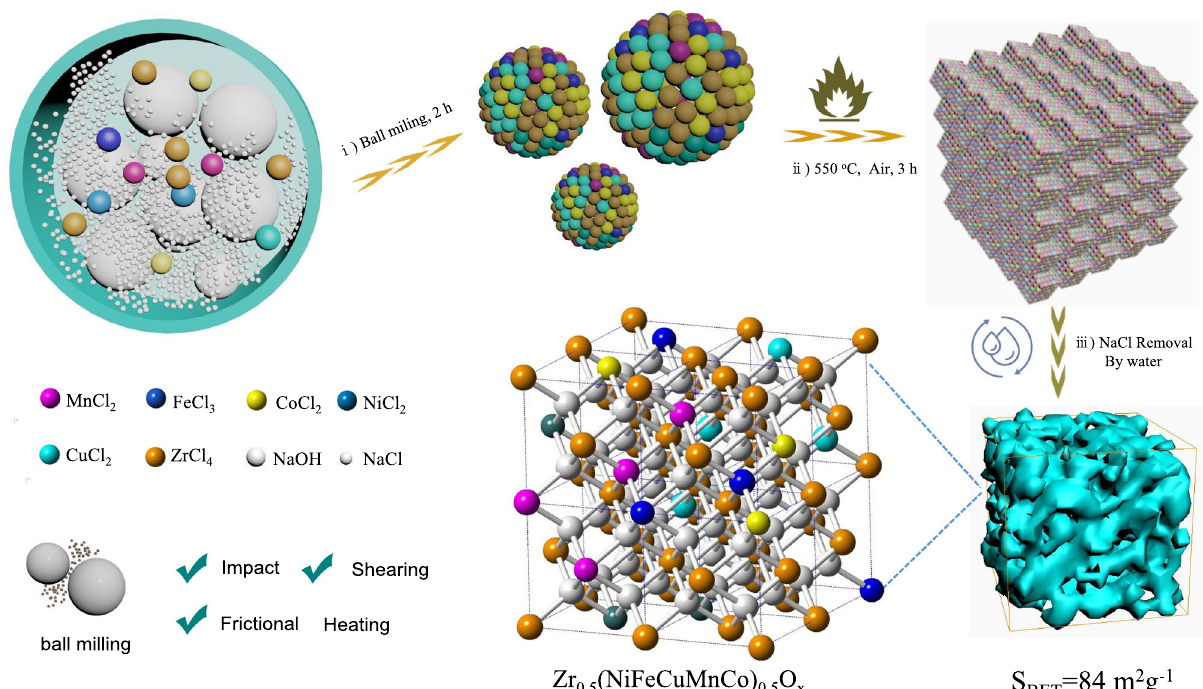
Fig. 2 The synthetic route of entropy-stabilized Zr 0.5 (NiFeCuMnCo) 0.5 O x. i Mixing metal chlorates ZrCl 4 , MnCl 2, NiCl 2 , FeCl 3 , CoCl 2 , CuCl 2 , NaCl and NaOH by ball milling. ii Calcination of the intermediate in air. iii Sodium salt removal from the composite by washing.